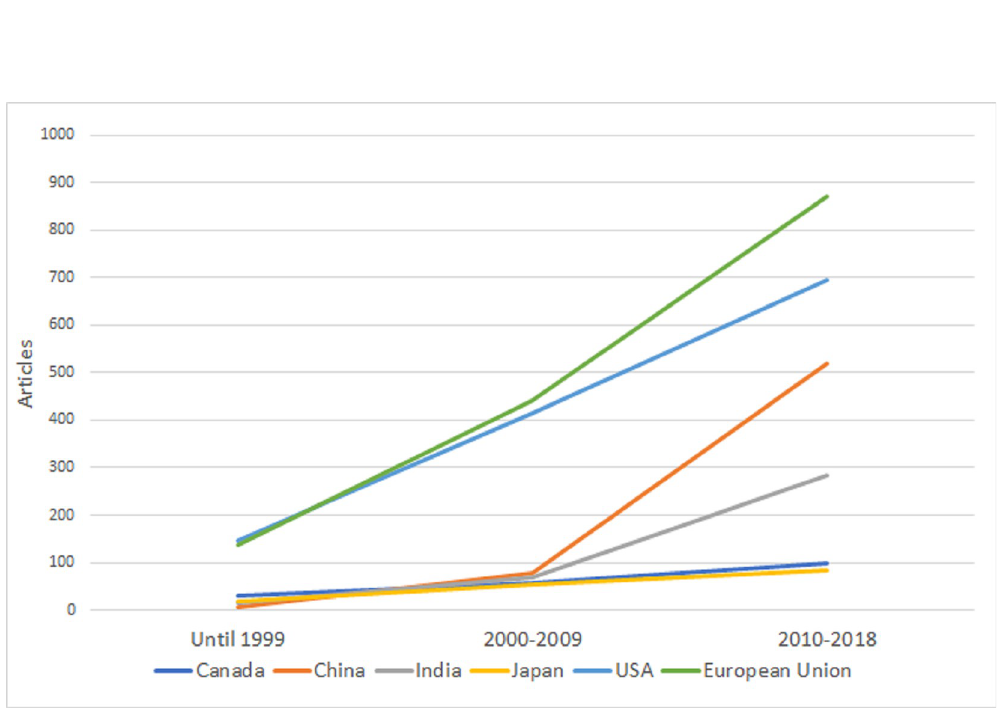
Fig 3. Evolution of published articles in the field of biocontrol using Bacillus amyloliquefaciens strains. The vertical axis represents the number of articles published in each of the 3 periods analyzed (until 1999, 2000–2009, and 2010–2018) by country (Canada, China, Japan, and the USA) or regulatory region (European